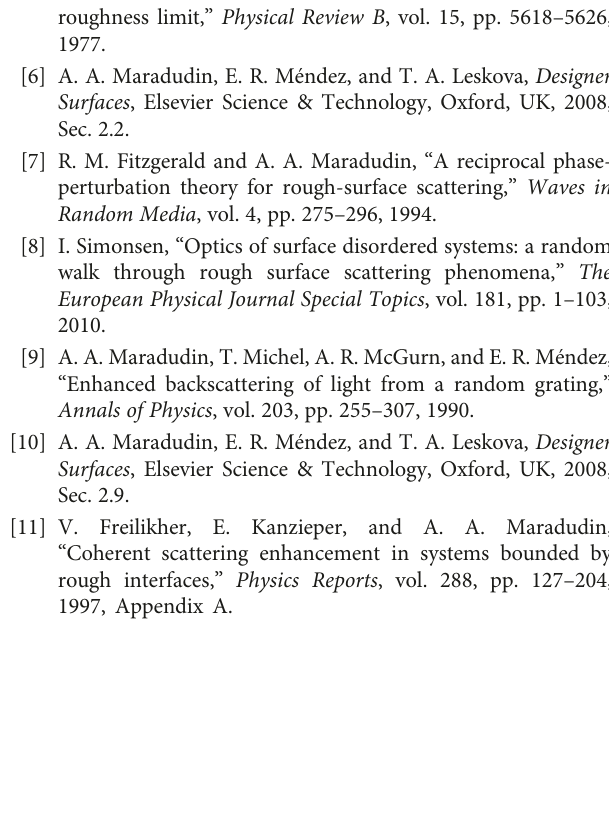
= 2 25 and ε = 1 1 2